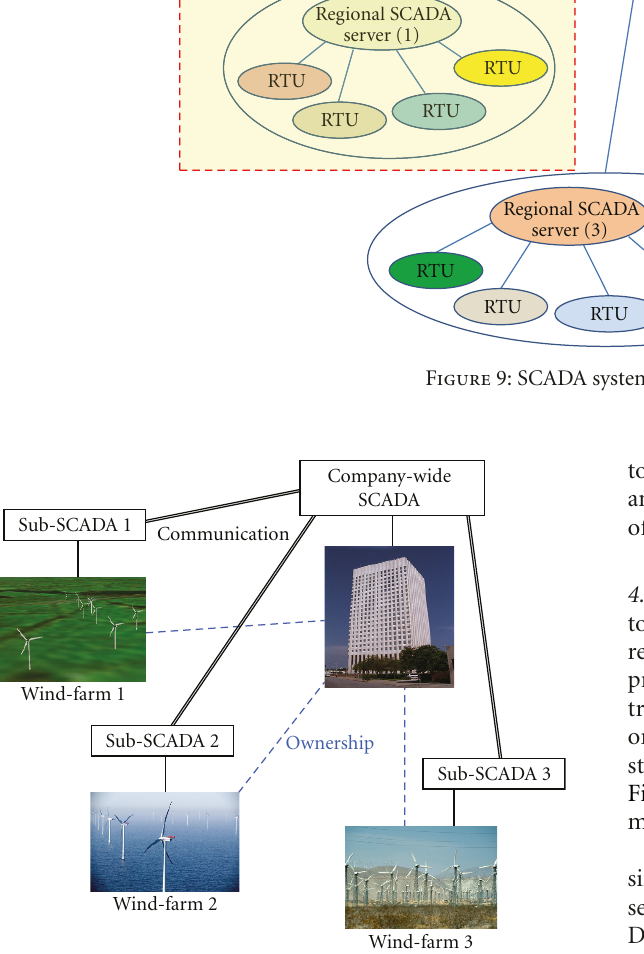
Figure 10: Wind farm SCADA